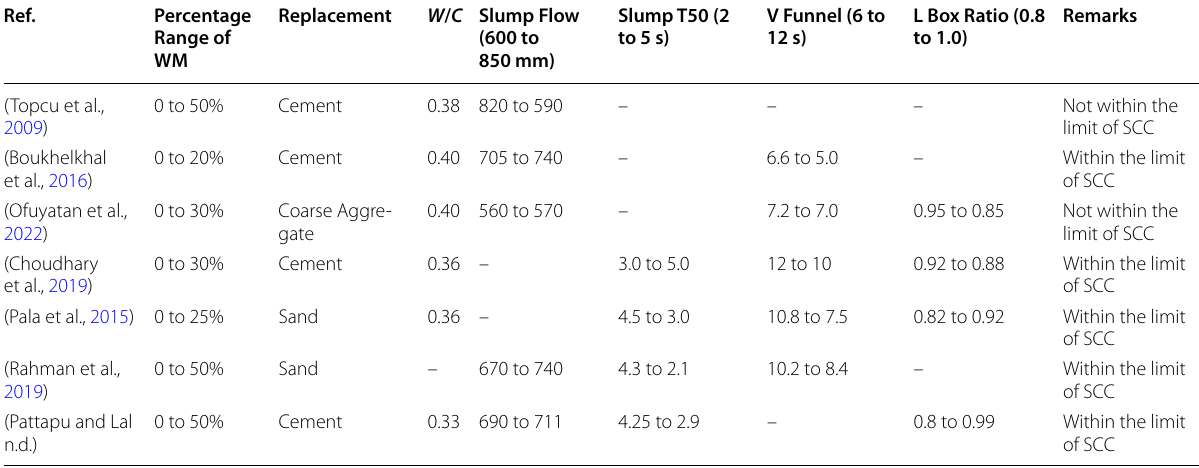
Table 1 Summary of filling and passing ability of concrete with WM